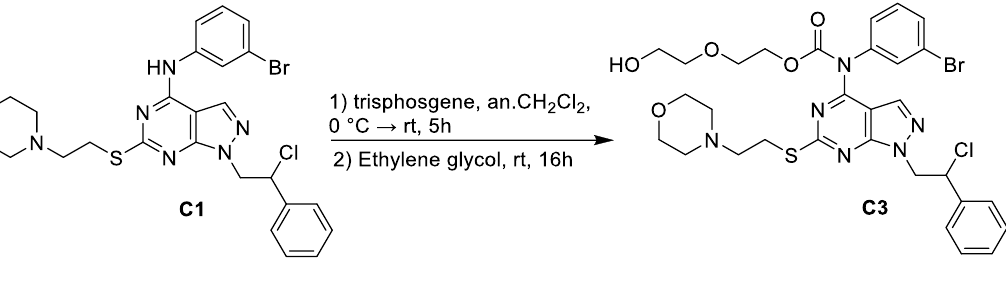
Figure 2. Synthesis of C3 .